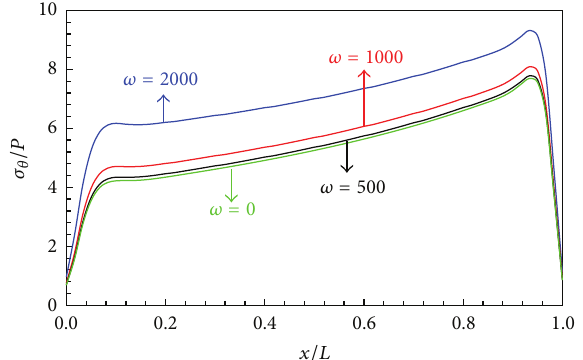
Figure 13: Shear stress distribution in middle